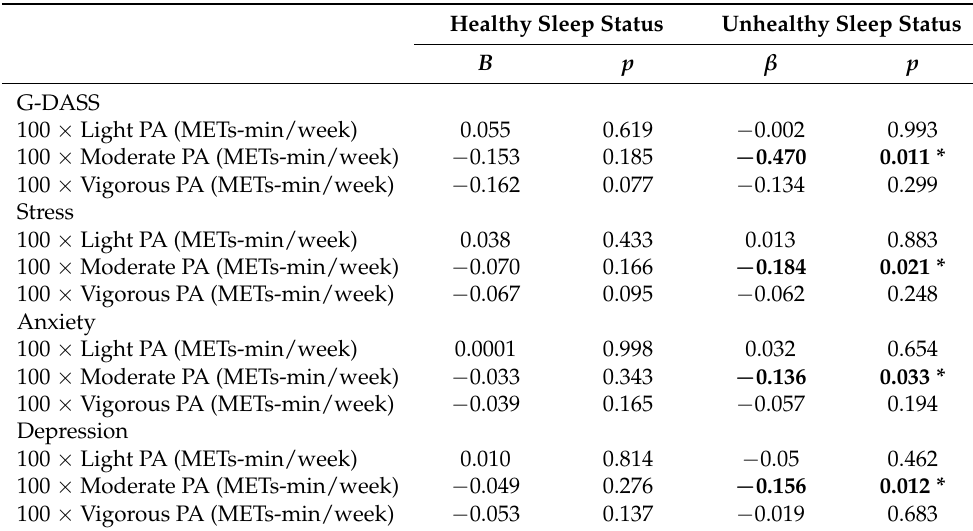
Table 2. Associations between various intensity physical activity and mental health indicators under healthy and unhealthy sleep status. Healthy Sleep